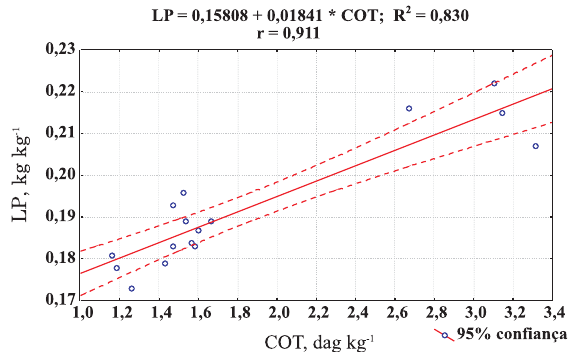
Figura 1. Relação entre o limite de plasticidade (LP) e o carbono orgânico total (COT) do solo, na profundidade de 0–0,20 m.